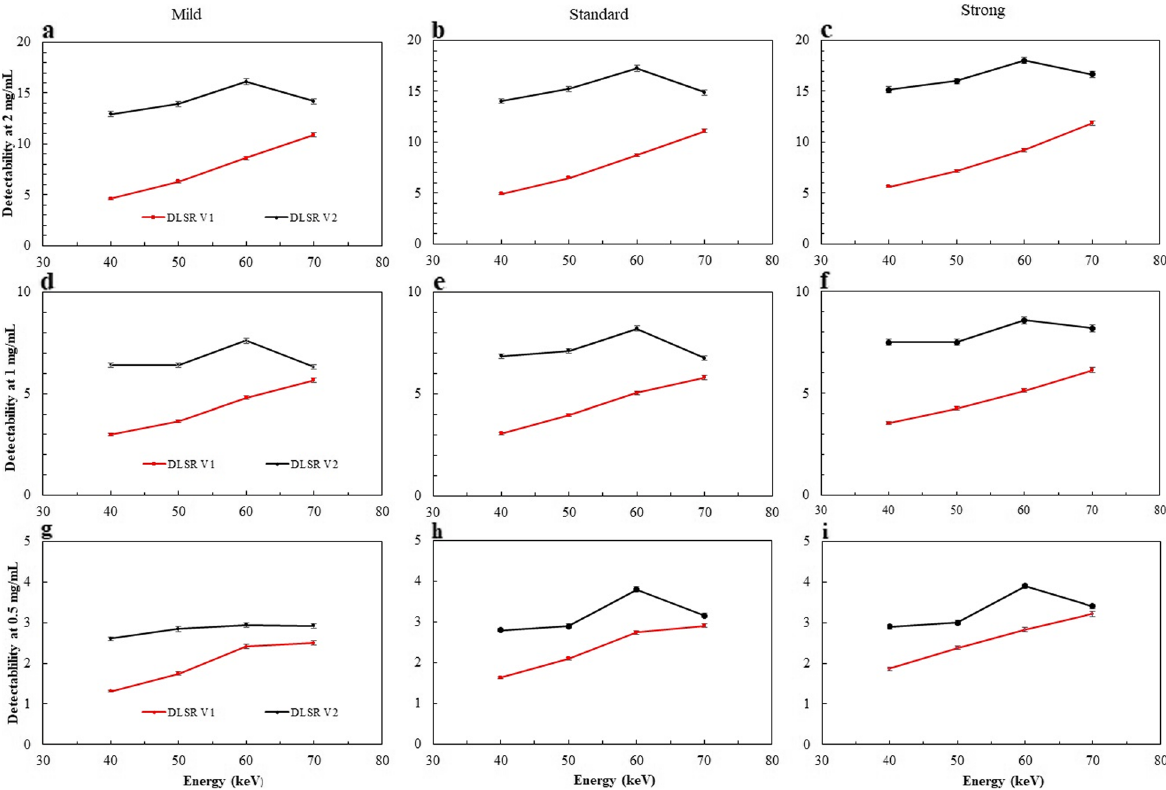
Fig. 5 Detectability index as function of the energy levels for three levels of deep learning spectral reconstruction (DLSR) versions (DLSR V1 and DLSR V2) and three iodine concentrations. a Mild level, 2 mg/mL iodine. b Standard level, 2 mg/mL iodine. c Strong level, 2 mg/mL iodine. d Mild level, 1 mg/mL iodine. e Standard level, 1 mg/mL iodine. f Strong level, 1 mg/mL iodine. g Mild level, 0.5 mg/mL iodine. h Standard level, 0.5 mg/mL iodine. i Strong level, 0.5 mg/mL